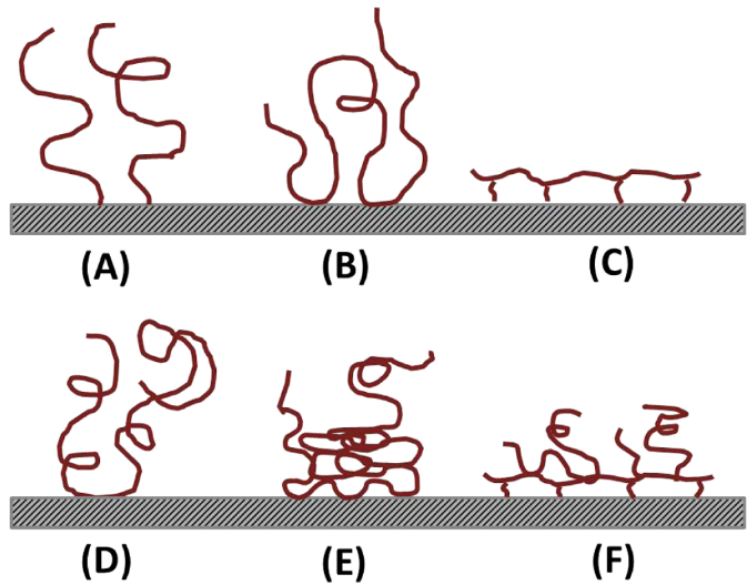
Figure 3. Possible conformations of polymer molecules after the adsorption on solid surfaces: ( A ) single point attachment (weak binding); ( B ) loop adsorption; ( C ) flat multiple site attachments (strong adsorption); ( D ) random coil (high molecular weight polymers); ( E ) nonuniform segment distribution; and ( F ) multilayer adsorption. (Reproduced from Alagha et al. (2013) [82], Copyright © 2021, with permission from the publisher).